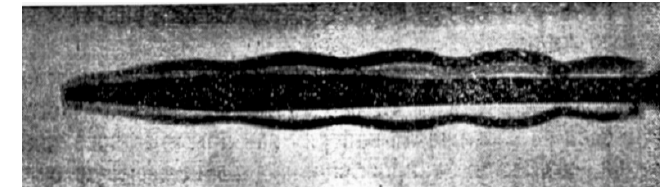
Figure 1. Cavity pulsation phenomenon.